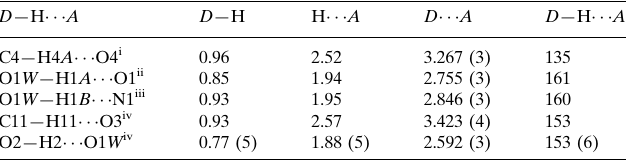
Hydrogen-bond geometry (A ˚ , (cid:2)